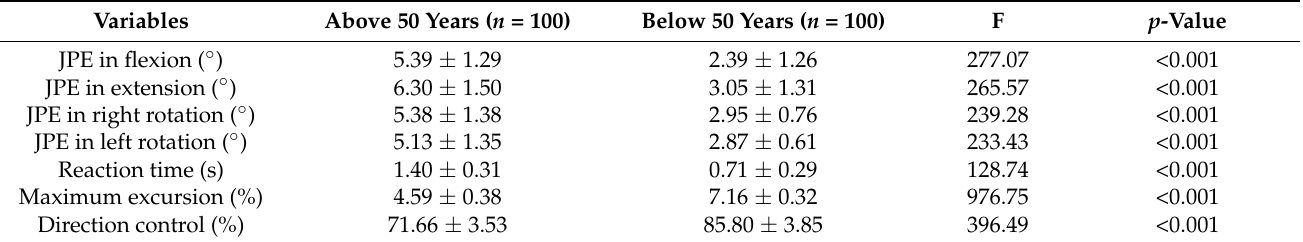
Table 2. Descriptive characteristics of cervical joint position sense and limits of stability tests.